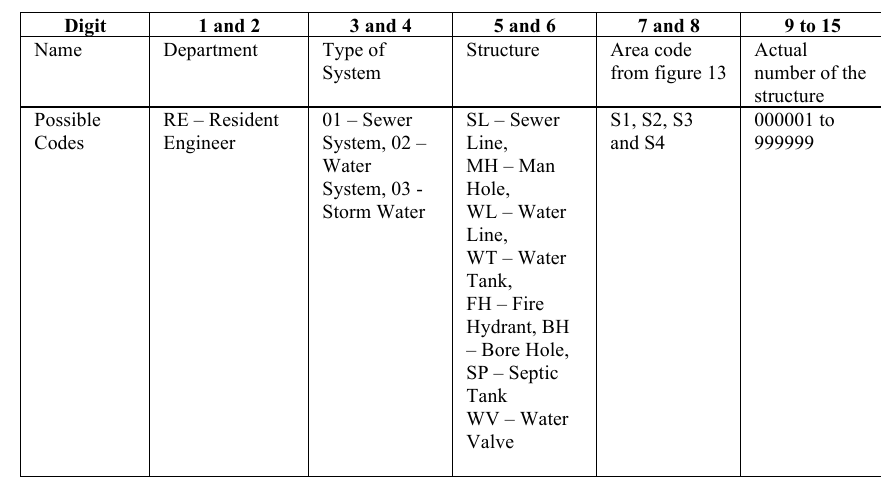
Table 1. Summary of the possible codes of the various